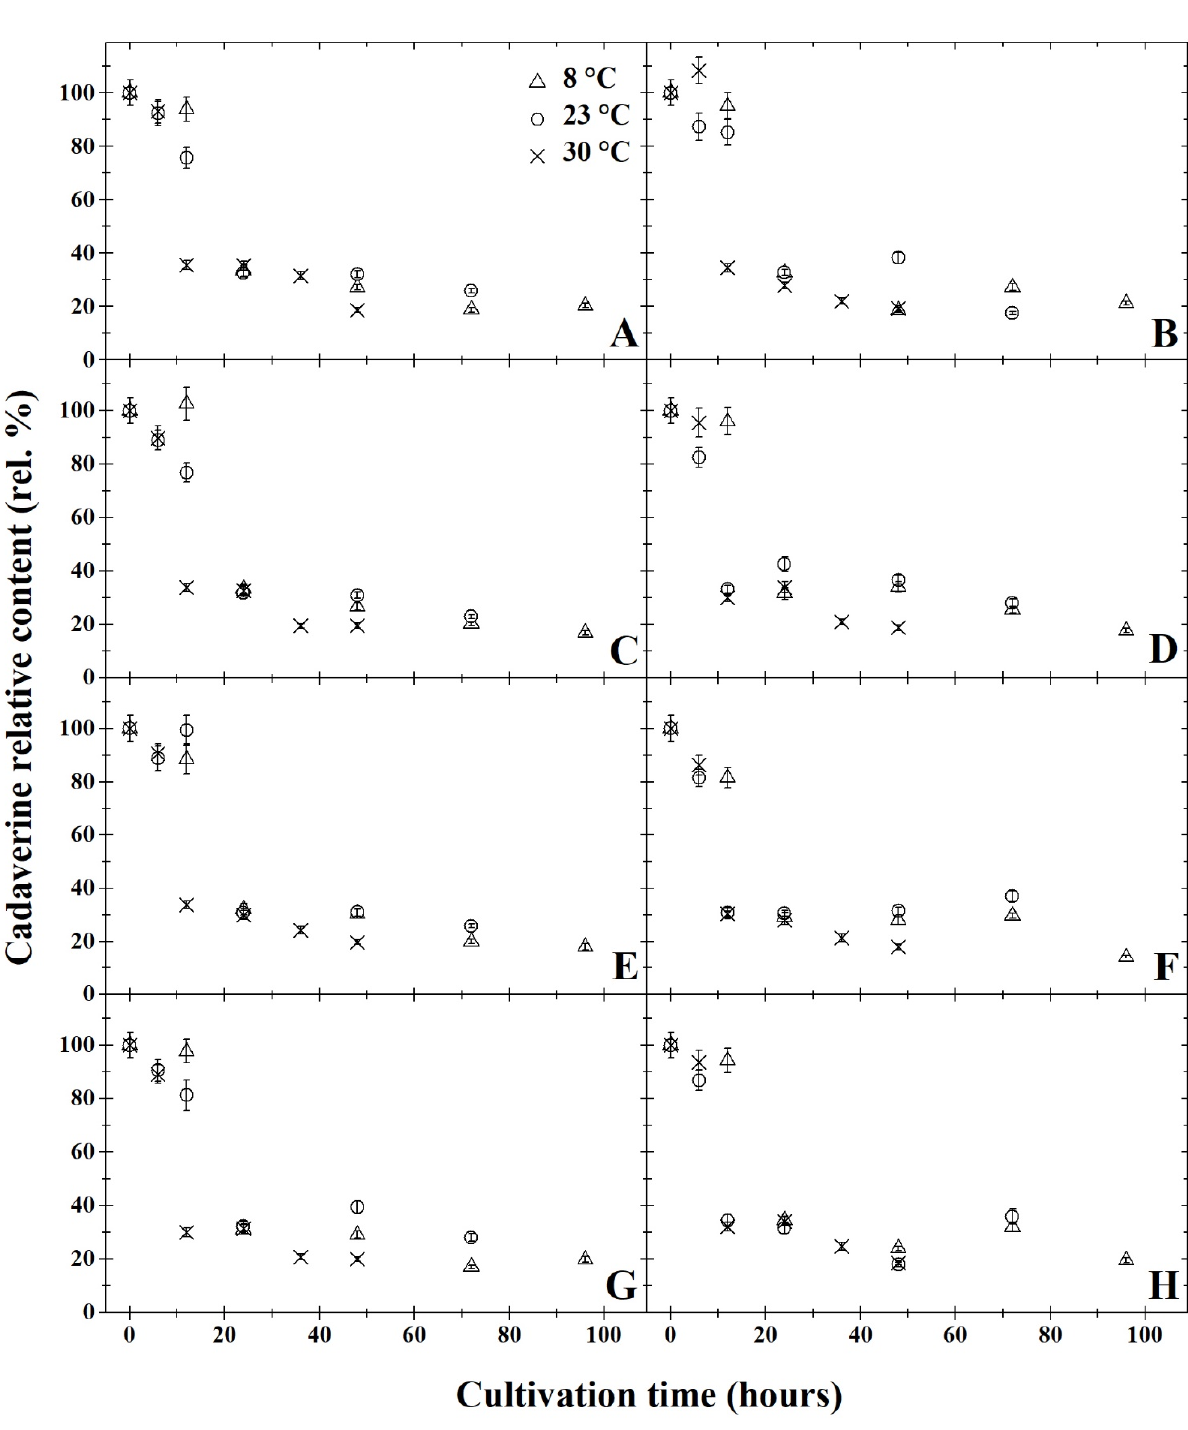
Figure 3. Development of cadaverine relative content (rel. %) by degradation using Bacillus subtilis DEPE IB1 in dependence on the cultivation time (hours); the initial cadaverine relative content at the time zero were always 100%. Parts ( A , C , E , G ) represent the results of anaerobic cultivation and parts ( B , D , F , H ) show the results of aerobic cultivation. Incubation was carried out under pH = 5 (parts A and B ), pH = 6 (parts C and D ), pH = 7 (parts E and F ), pH = 8 (parts G and H ). Three cultivation temperatures were used: 8 ◦ C ( (cid:52) ), 23 ◦ C ( ) and 30 ◦ C ( × ). The results were presented using the means and standard deviations (bars; n = 24).